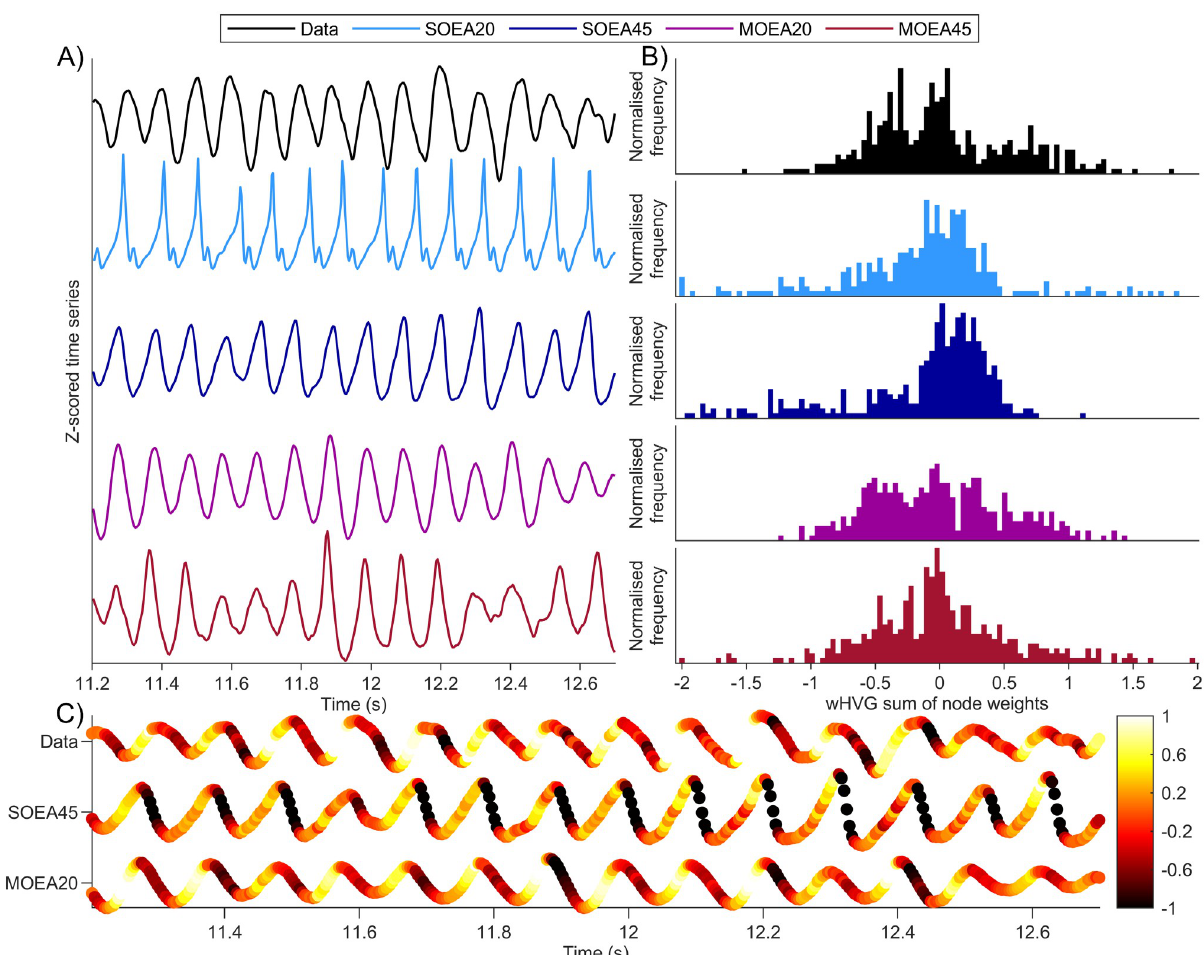
Fig 3. Illustration of wHVG distributions derived from the data presented in Fig 2A. A) 1.5s segments of data and model simulations at the optimal parameter set (colours as per legend). Optimal refers to the smallest Euclidean distance from the origin in objective space. B) the corresponding wHVG distributions derived from the time series segments in A). These histograms give the wHVG frequency from 100 equally sized bins (see Methods). C) the time series from the data, SOEA45 and MOEA20 simulations, as shown in A), with time points (i.e. wHVG nodes) coloured according to their node weight (normalised between -1 and 1 to remove